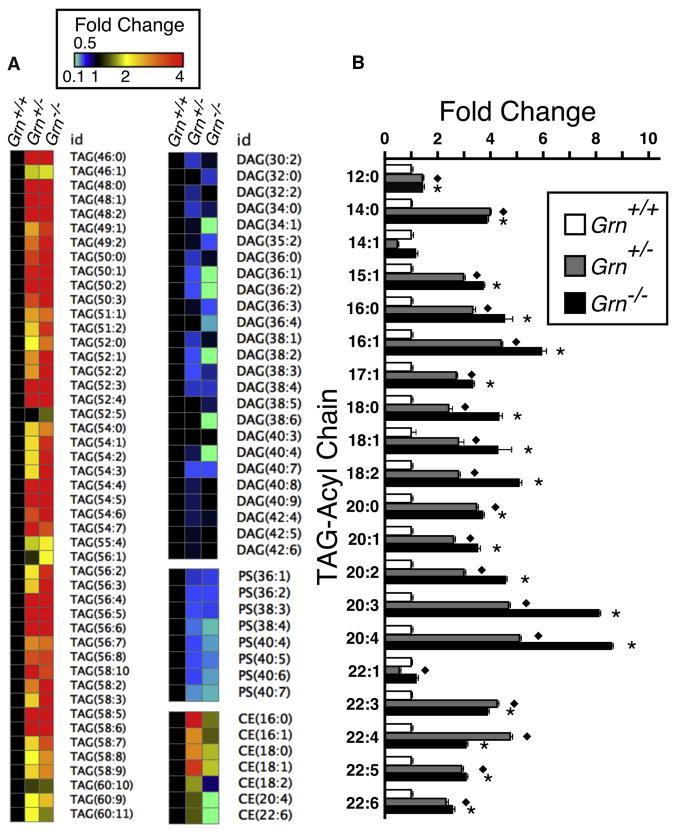
Relative Changes in Individual Lipid Species between Wild-Type and Grn Mutant MEFs(A) Heatmap of individual species of TAG, DAG, PS, and CE in Grn+/+, Grn+/−, and Grn−/− MEFs (n = 3; Table S2G). Data are normalized to Grn+/+ values.(B) Plot of fold changes in select TAGs of various acyl chain lengths and unsaturation levels in Grn+/+, Grn+/−, and Grn−/− MEFs (n = 3). Data are presented as mean ± SEM; two-tailed Student's t test; p < 0.05 between Grn+/+ and Grn+/− (diamond) or Grn−/− (asterisk). Data are normalized to Grn+/+ values.